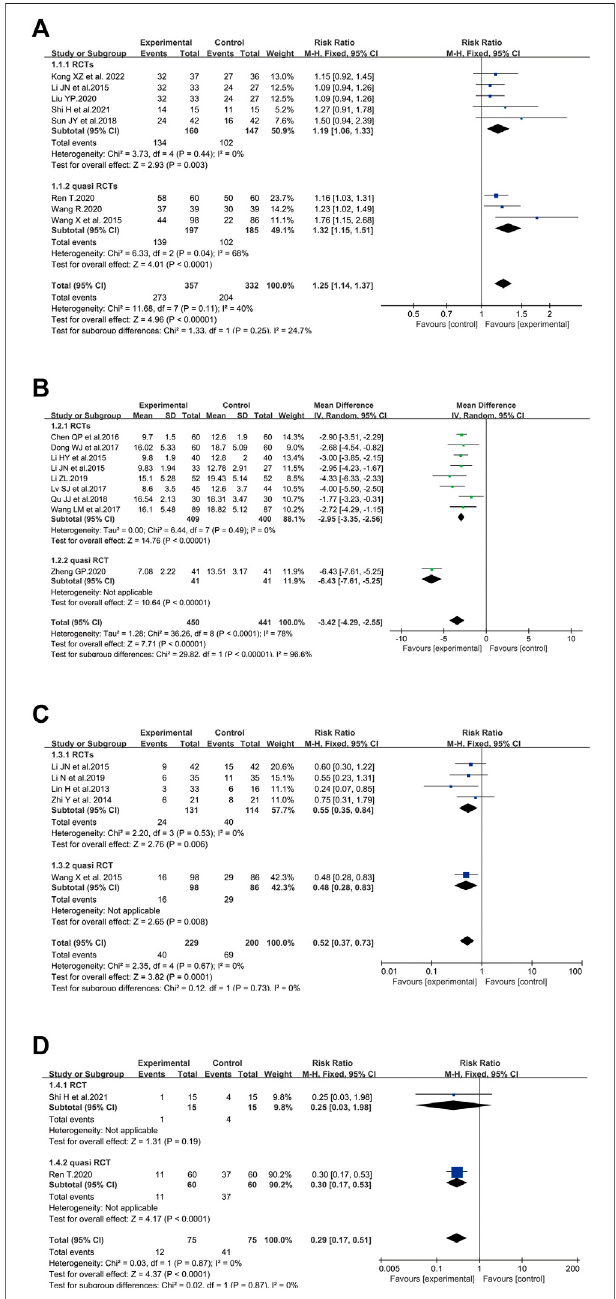
FIGURE 3 | Meta-analysis results of SFI on primary outcomes: (A) total effective rate; (B) APACHE II score; (C) mortality rate; (D) safety concern.